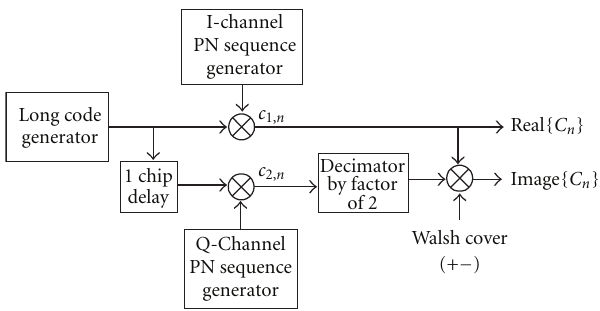
Figure 2: Block diagram of CDMA 1x spreading sequence genera- tion.